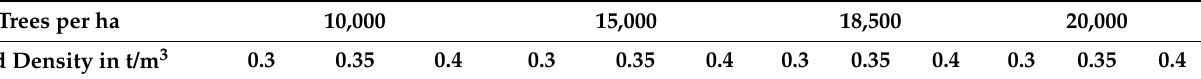
Table 9. Yield expectation table [t/ha*a] for different tree densities between 10,000 and 20,000 trees per hectare and wood densities between 0.3 to 0.4 t/m 3 for each cultivar for the site Bishkek 1. The stem volumes used to calculate yields were measured at the end of the growing season 2019 as listed in Table 8. The values for wood densities were taken from own observations and center around the value of 0.35 t/m 3 , which is given by FAO (http://www.fao.org/3/j2132s/J2132S16.htm, assessed on 10 January 2021). Grey boxes mark economically viable values of more than 8 t biomass per hectare and year. The total of 18,500 plants per hectare represents the real planting density of this site. For the calculations here, a survival rate of 100% was assumed for all cultivars.